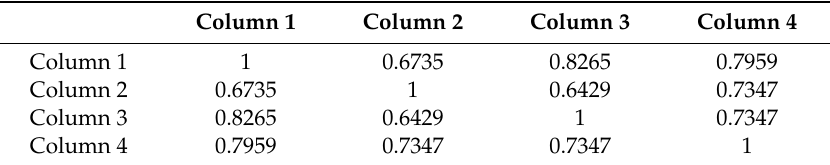
Table A3. Spearman correlation (see Table 1).